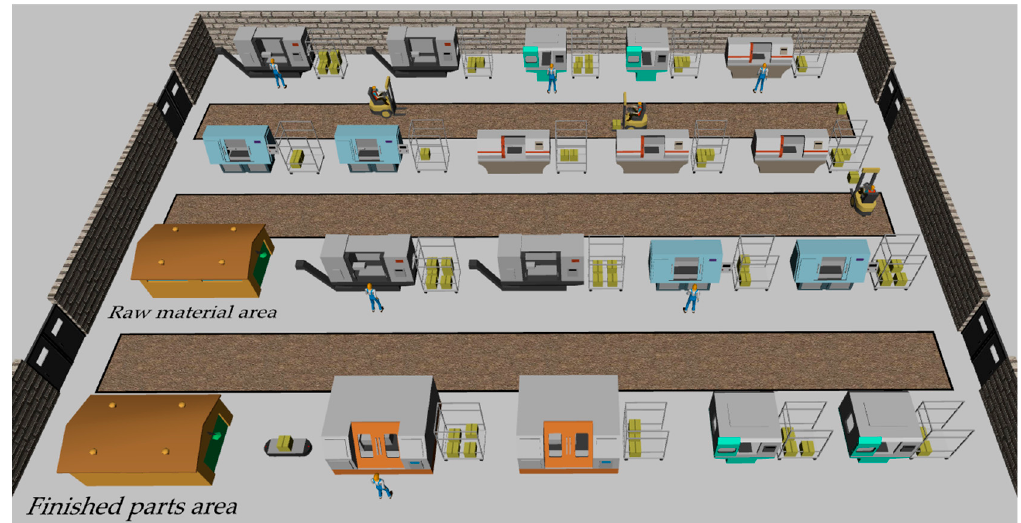
Figure 4. 3D view of the production cell.